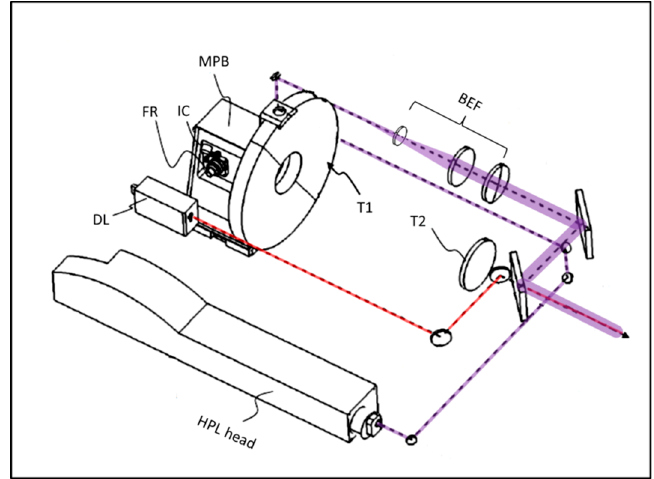
Figure 3. A simplified drawing of the overall optical system where DL is the distance-meter, T1 and T2 are telescope mirrors, MPB is the multiplexer box, FR is the fiber attachment for Raman, and IC is the internal camera. The violet thick line indicates the high-power laser beam, while the red line indicates the beam from the DL.